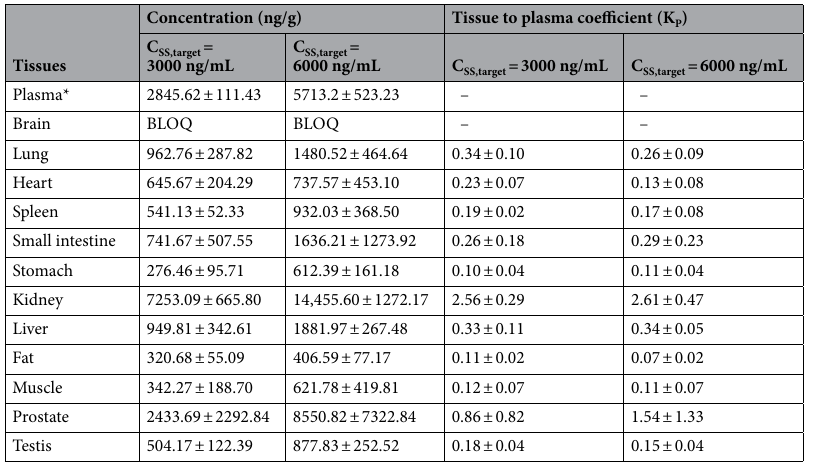
Table 2. Average concentrations of 175 Lu-DOTA-PSMA-GUL and tissue to plasma partition coefficient (K P ) in tissues obtained following simultaneous intravenous bolus injection (loading bolus dose 0.60 and 1.20 mg/ kg) plus continuous intravenous infusion (infusion rate 1.82 and 3.65 mg/h/kg) in rats (n = 5, each). *Plasma concentrations are in ng/mL; BLOQ, below the lower limit of